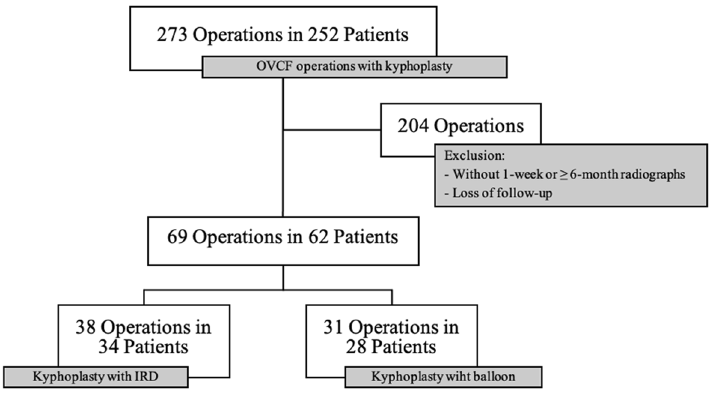
Figure 2. Flowchart illustrating the inclusion process. ( OVCF osteoporotic vertebral compression fracture, IRD intravertebral reduction